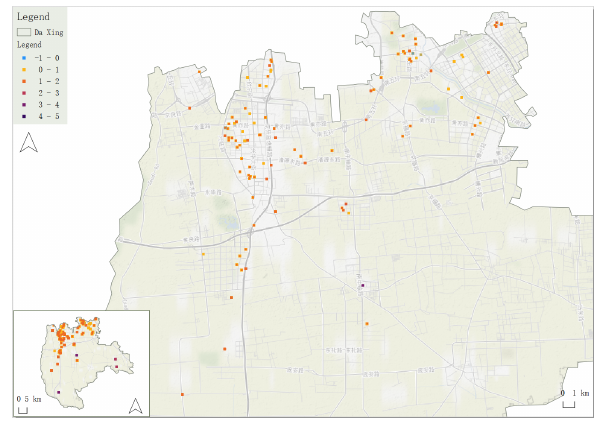
Figure 10. Sensitivity score of neighbourhoods in Da Xing.